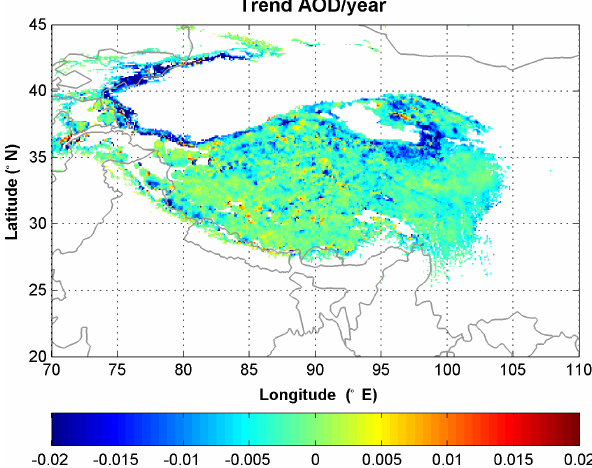
Figure 8. Trend in the MODIS_AOD at 550nm during 2006–2017.